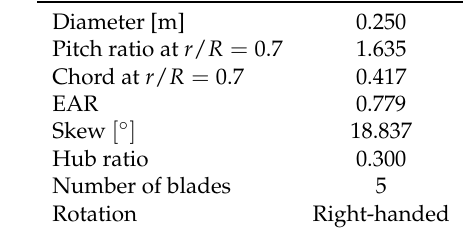
Table 1. Main geometric parameters of the Potsdam propeller test case (PPTC) propeller [26].